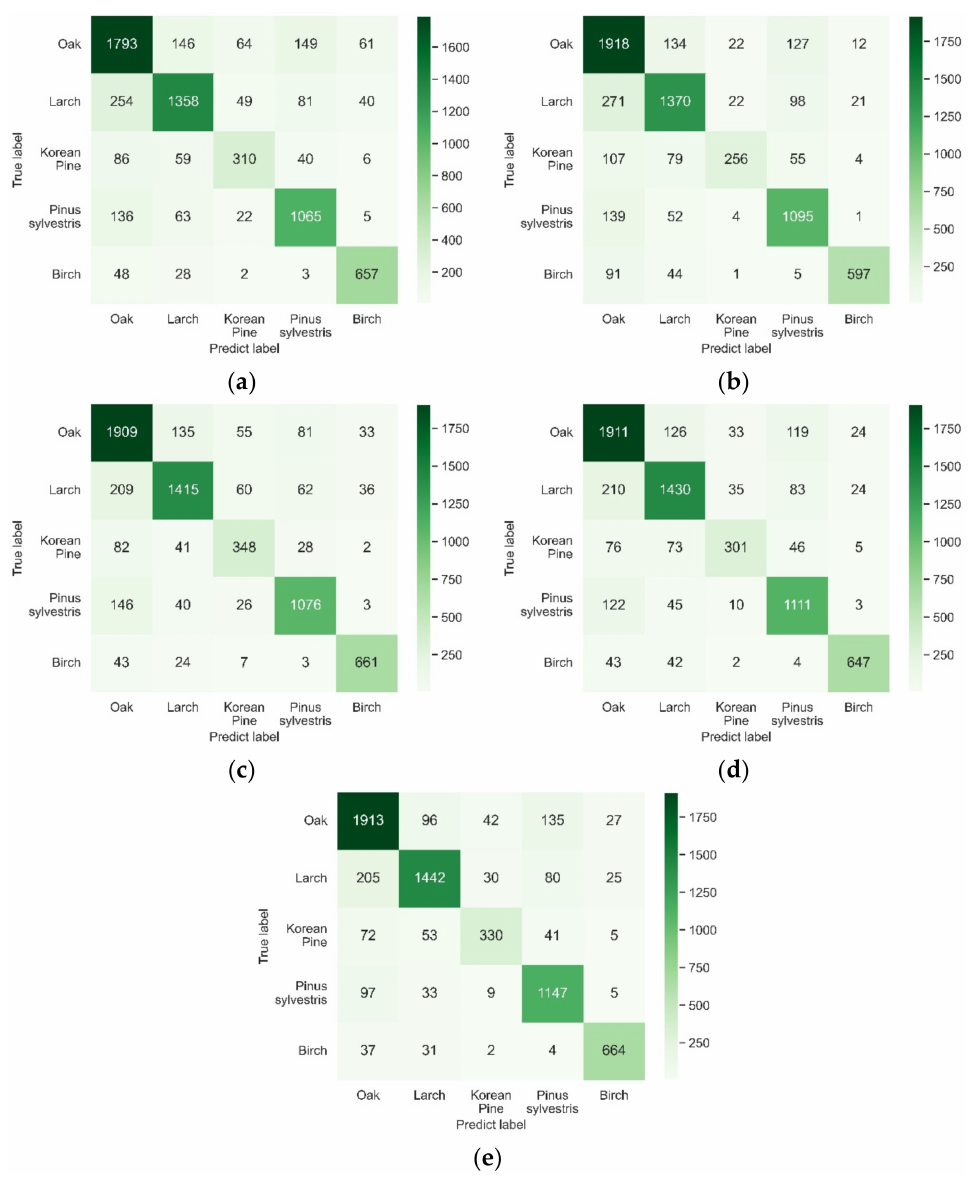
Figure 10. Confusion matrix for various classification methods: ( a ) KNN; ( b ) RF; ( c ) ANN; ( d ) Light- GBM; ( e ) ensemble.